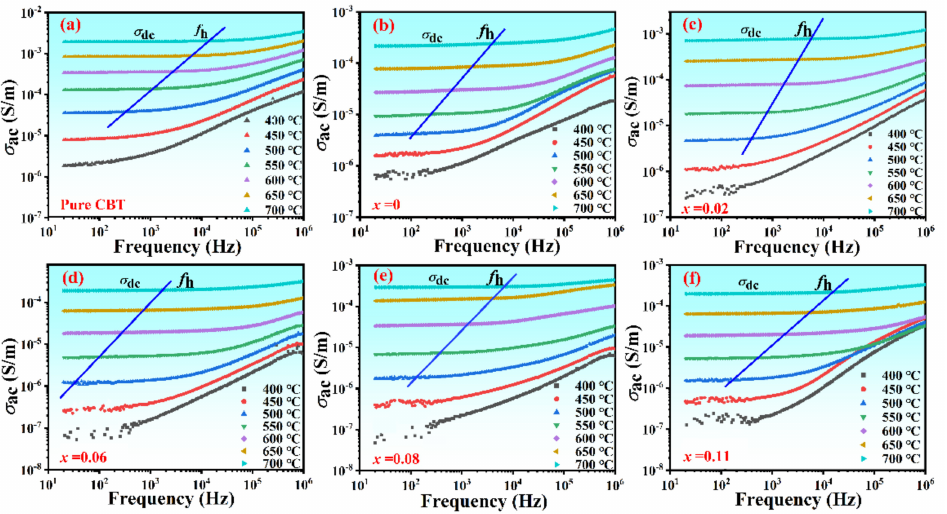
Figure 4. Frequency dependence of AC conductivity of the CBT − x Gd/0.2Mn ceramics measured at different